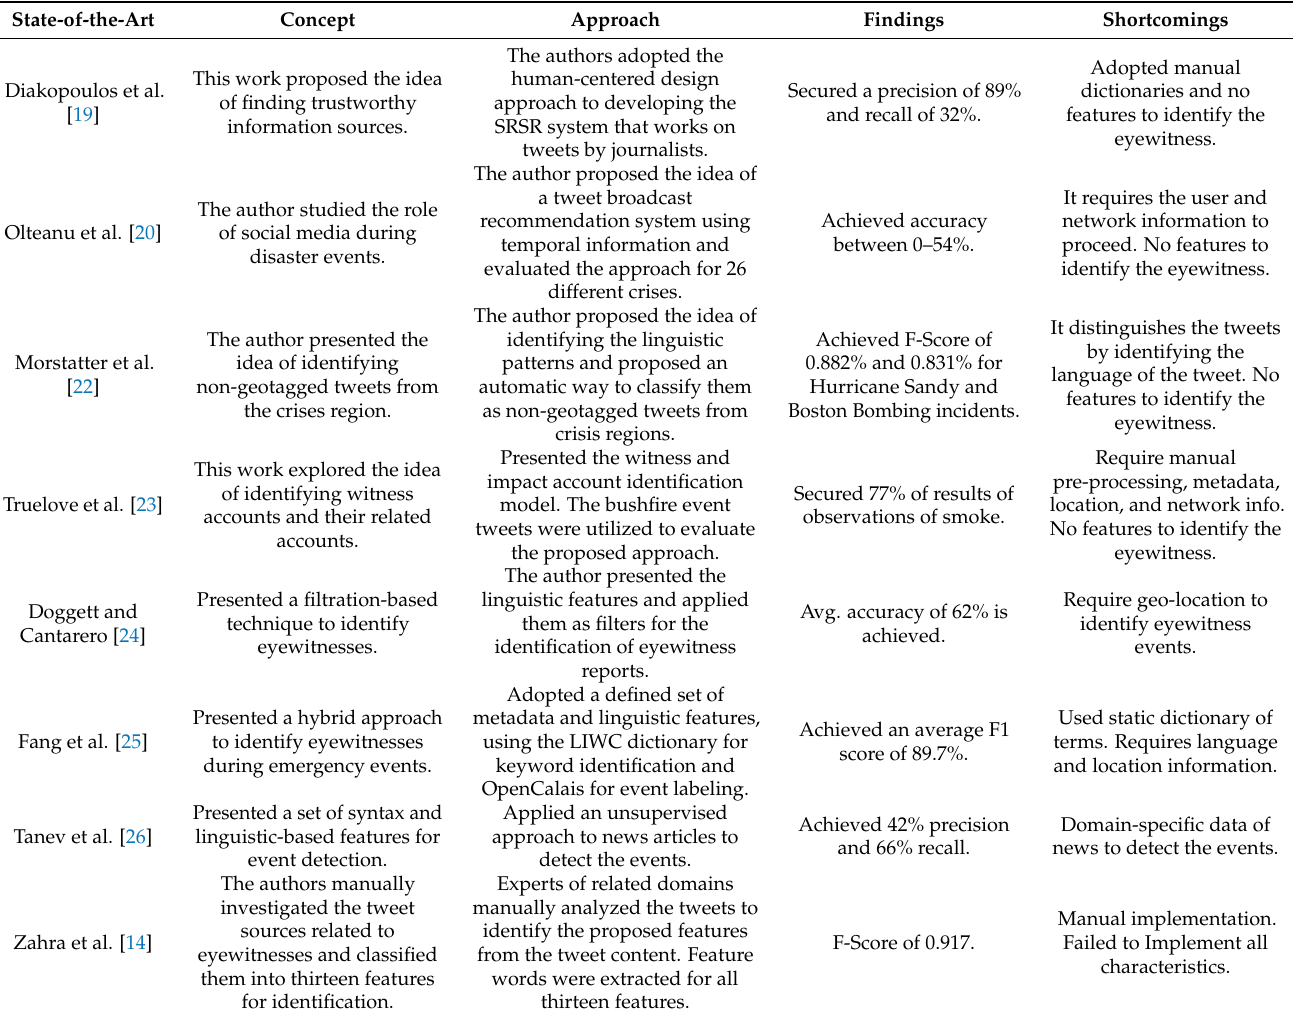
Table 2. Summary of Eyewitness Identification